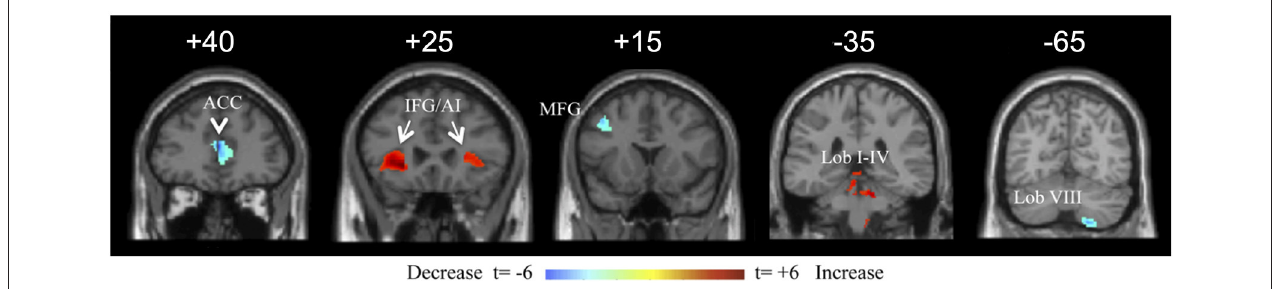
FIGURE 5 | Coronal view of a selection of brain regions with volume changes as a function of duration of illness of mal de débarquement syndrome (MdDS). Blue indicates volume decrease with duration of illness; red indicates volume increase with duration of illness. Coordinates of peak significance are indicated in parentheses. In SPM, negative X -values are on the left and positive on the right. ACC, anterior cingulate cortex [Montreal Neurological Institute (MNI): ± 2, 40, 13). IFG/AI: inferior frontal gyrus/anterior insula (MNI: − 26, 30, − 3 and 27, 24, 4). MFG: middle frontal gyrus (MNI: − 42, 15, 43). Lob I–IV: cerebellar lobules I–IV (MNI: − 6, − 38, − 17 and 8, − 50, − 27). Lob VIII: cerebellar lobule VIII (18, − 66, − 55). Images are shown at the Y coordinate indicated above each image. Figure adapted from Cha YH and Chakrapani S, PLOS One 2015